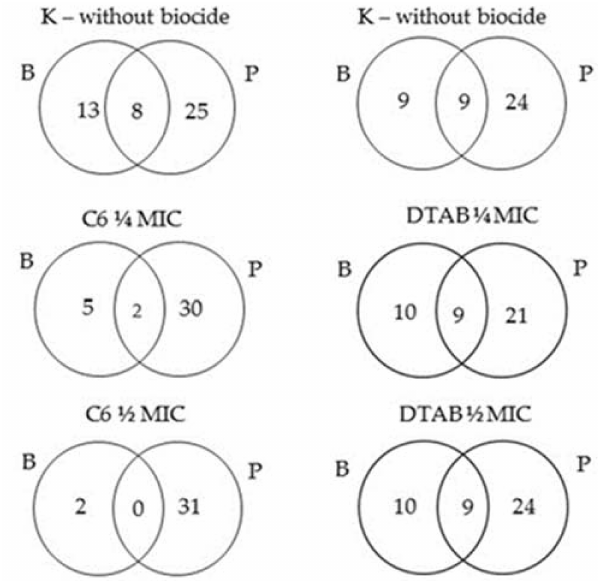
Figure 5. Venn diagram showing the numbers of protein bands in biofilm (B) and planktonic cells (P) o P. aeruginosa PB_1 after 24-h treatment with gemini C6 and monomeric DTAB